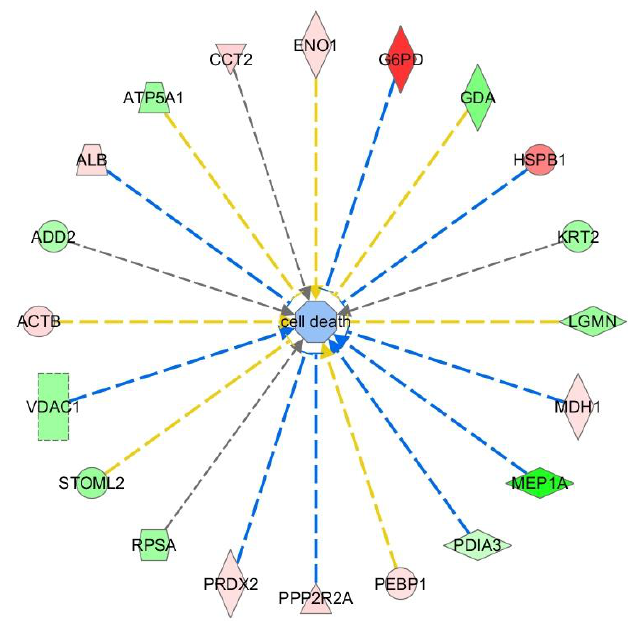
Figure 2. Proteins with influence on cell-death related signal transduction (green/light green: up-regulation, red/light red: down-regulation).